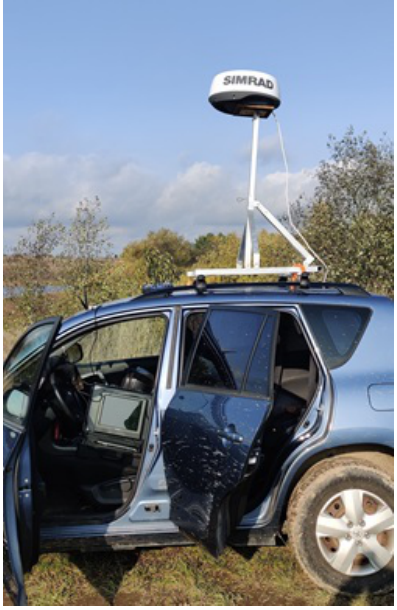
Figure 3. Arrangement of the radar on the car roof.